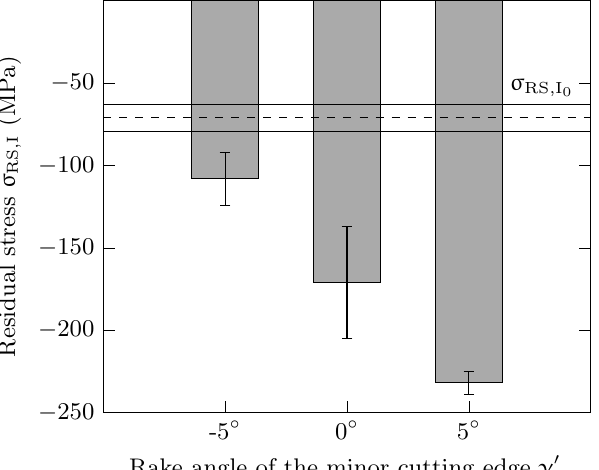
Figure 14. Residual stress σ RS,I for different rake angles γ (cid:48) o of the minor cutting edge ( v c = 250m/min, f z = 0.015mm, a p = 0.25mm, a e = 0.5mm, α (cid:48) o = 2 ◦